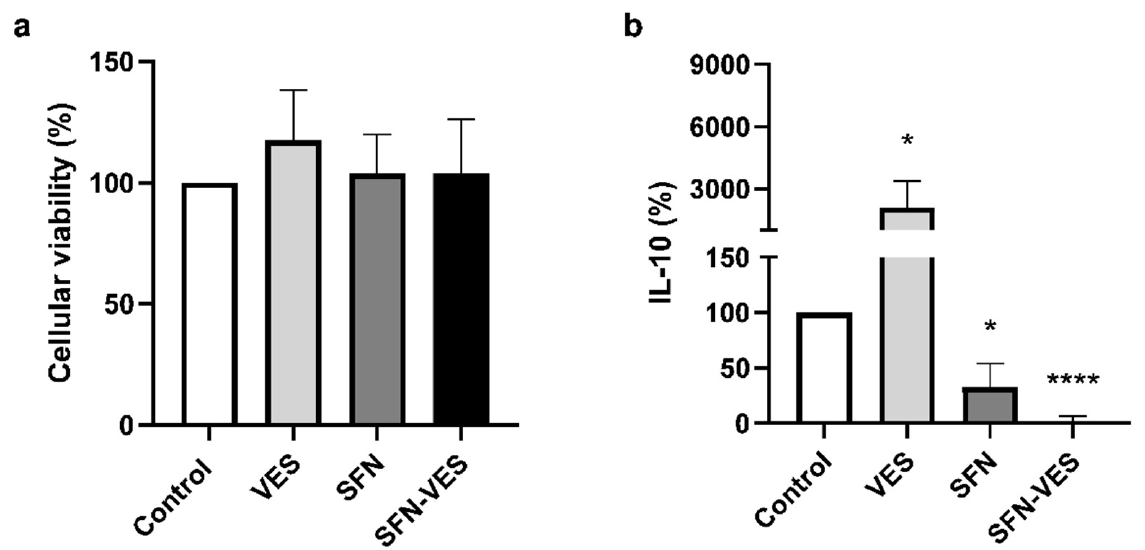
Figure 7. Analysis of viability and secretion of IL-10 in M2 macrophages treated with Brassica compounds. Primary cultures of human M2 macrophages were untreated (Control) or treated for 24 h with unloaded broccoli membrane vesicles 0.02 mg/mL (VES), free sulforaphane 25 µM (SFN), or SFN-loaded broccoli membrane vesicles at 25 µM (SFN-VES). Cell viability ( a ) and IL-10 production ( b ) was assessed in M2 macrophages from 4 healthy donors. Data were normalized relative to the untreated control (valued as 100%) and represented as mean ± SEM. Significant differences with respect to the untreated control (*) was calculated according to the one-way ANOVA analysis with a Tukey’s test as a post hoc test (* p < 0.05, **** p < 0.0001).